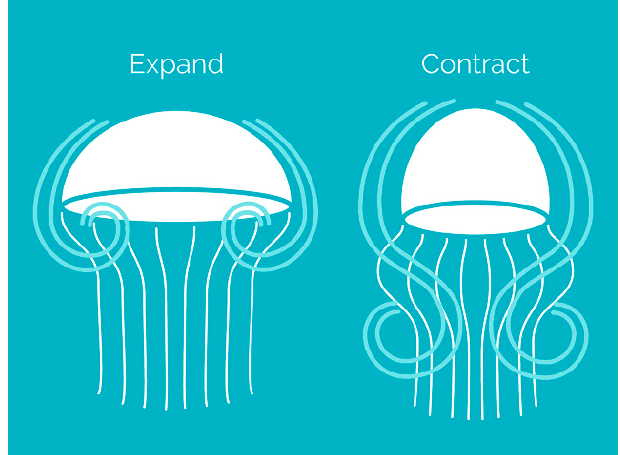
Figure 2. Propulsion mechanism of the Jellyfish.